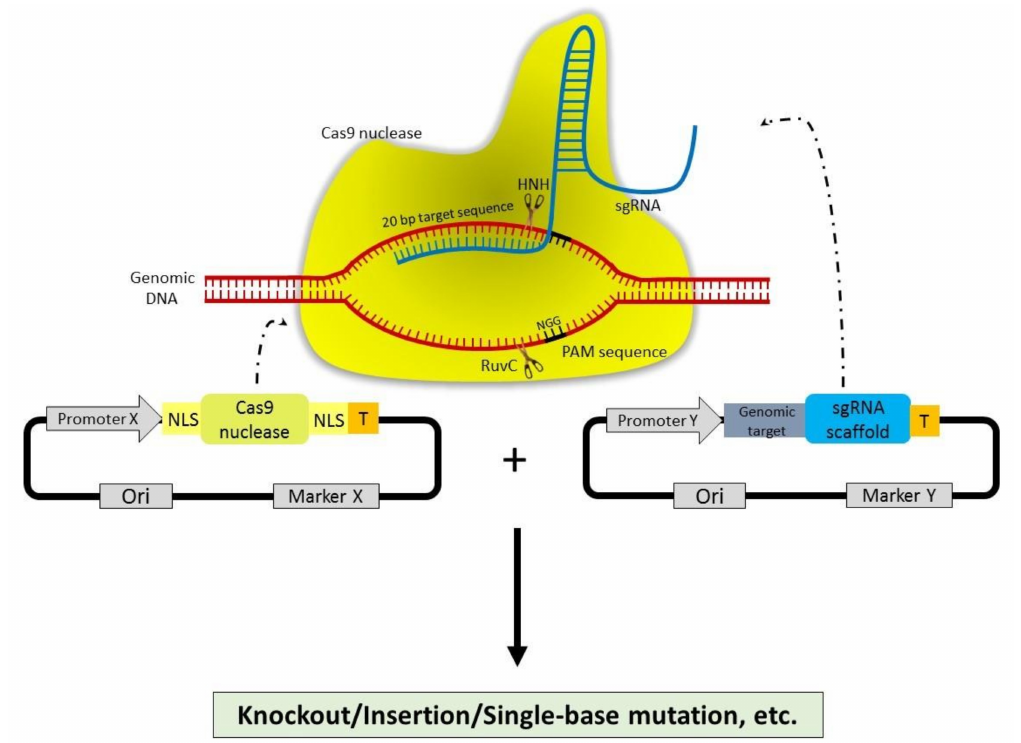
Figure 2. Schematic representation of RNA-guided Cas9 constructs designed for genome editing. Bottom panel: (structure of the vector plasmids used to deliver Cas9-sgRNA components into fungal cells). PromoterX can express NLS-Cas9-NLS protein. PromoterY can express 20 nt guide sequence + sgRNA cassette. Upper panel: (Cas9+sgRNA+genomic DNA). Mechanism of Cas9/gRNA ribonucleoprotein complex action, NGG (PAM site) highlighted in black line. The Cas9 nuclease domain HNH then cleaves the target DNA sequence complementary to the 20 bp guide sequence, while RuvC domain cuts another DNA strand, forming a double stranded break (DSB). DSB must be repaired via either non-homologous end joining (NHEJ) or homologous recombination (HR) immediately to avoid cell death. Insertions and deletion mutations at the target site generated by NHEJ and homology directed repair (HDR) allow disrupting or abolishing the function of a target gene. Moreover, modifications in this system can also be used to silence genes, insert new exogenous DNA, or block RNA